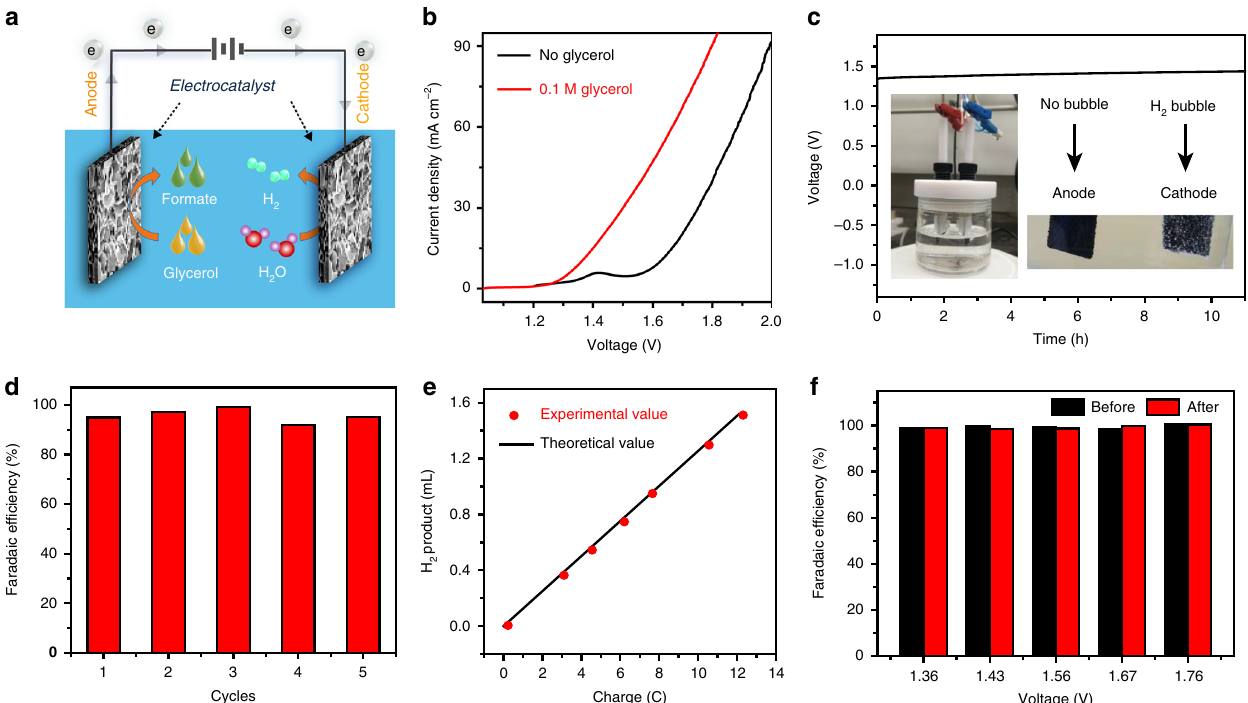
Fig. 7 Electrochemical performances of Ni – Mo – N/CFC || Ni – Mo – N/CFC. a Schematic illustration for concurrent electrolytic hydrogen and formate productions from glycerol solution. b LSV curves for the Ni – Mo – N/CFC || Ni – Mo – N/CFC cell in 1.0 M KOH solution with and without 0.1 M glycerol addition. Scan rate, 2 mV s − 1 . c Stability test of the Ni – Mo – N/CFC couple in the cell at a constant current density of 10 mA cm − 2 in 1.0 M KOH containing 0.1 M glycerol. d FEs of the Ni – Mo – N/CFC couple for formate production for fi ve successive electrolysis cycles. e Comparison between theoretical calculation and experimental measurement of H 2 evolution, indicating an up to 100% FE for H 2 production on Ni – Mo – N/CFC catalysts. f FEs of the Ni – Mo – N/CFC couple for H 2 at different potentials from the beginning to the end of 12 h glycerol